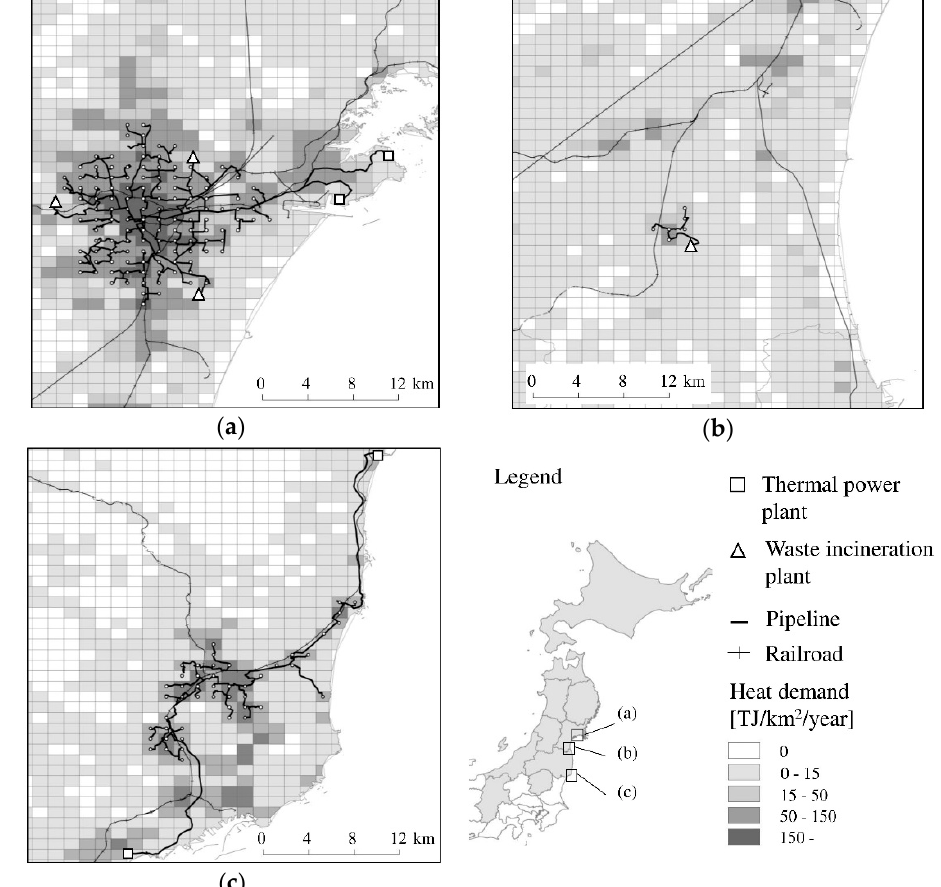
Energies 2019 , 12 , x FOR PEER REVIEW 11 of 14 Table 4. DHS characteristics for three cities.